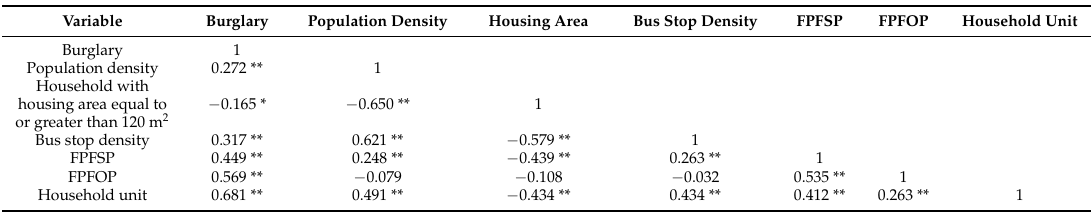
Table 2. Bivariate correlation coefficient for explanatory variables.